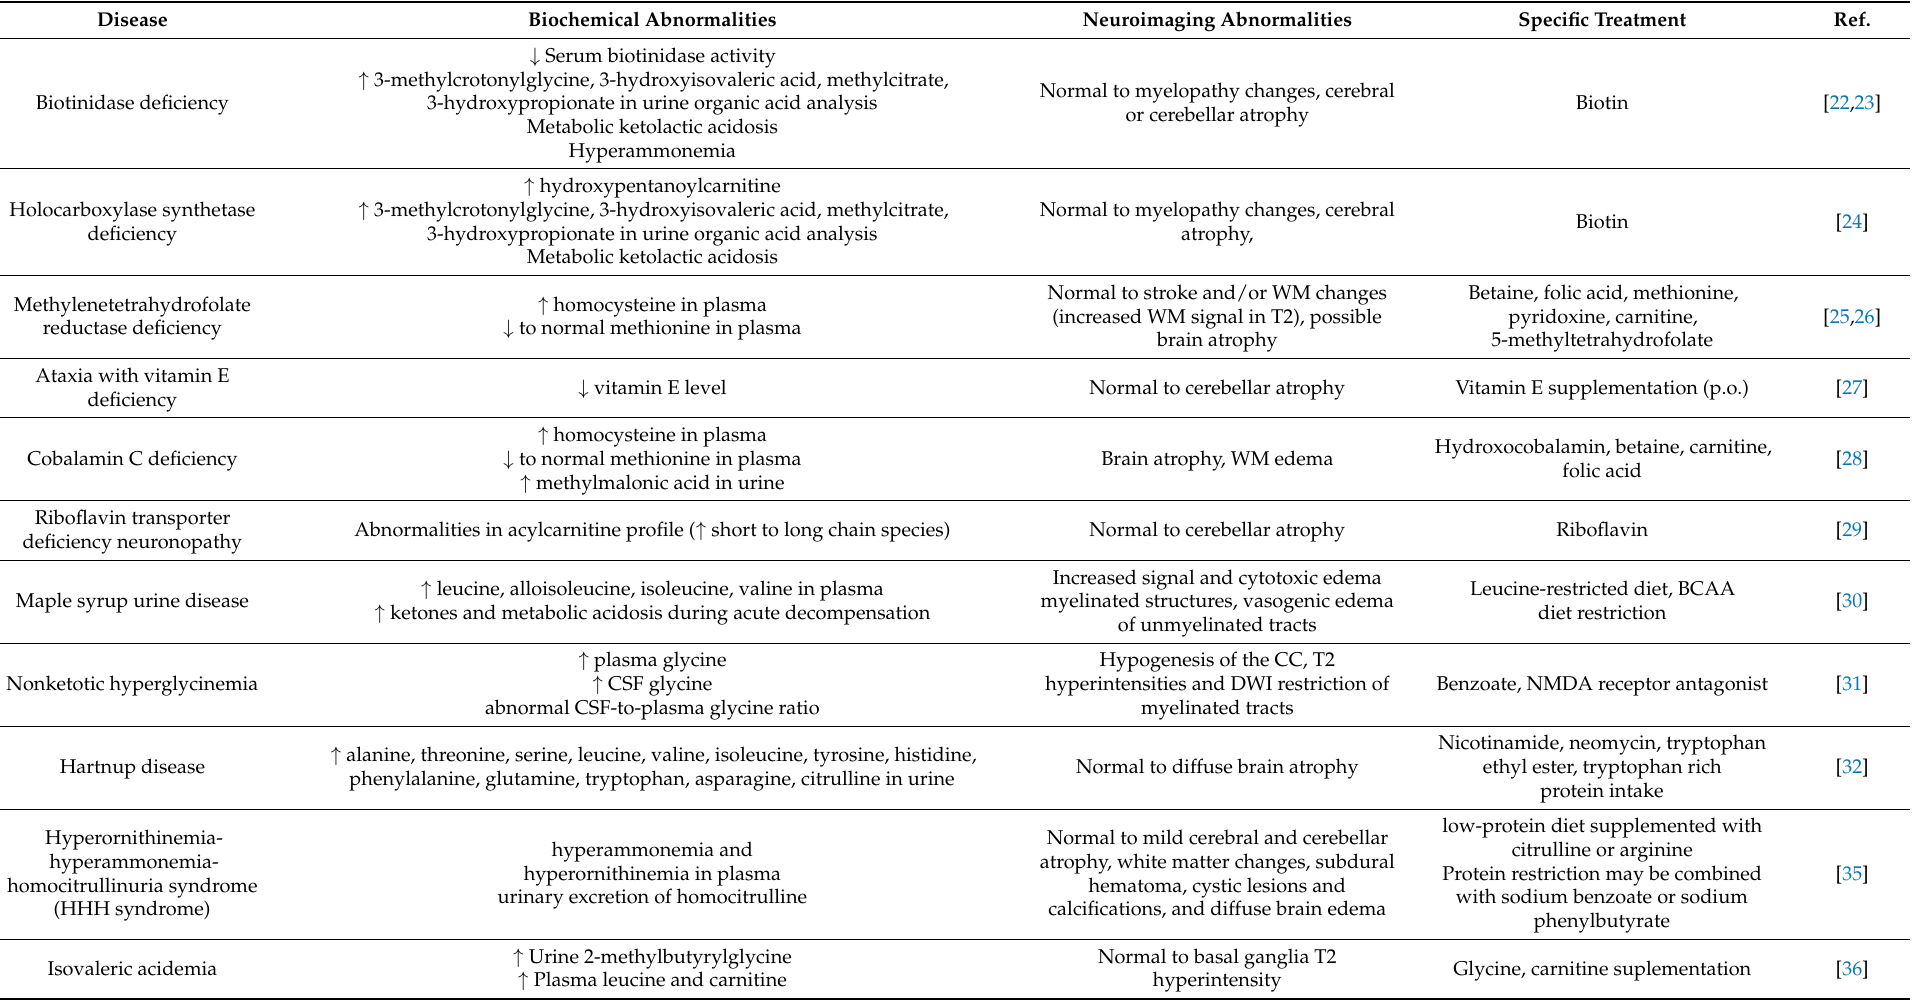
Table 3. Neurometabolic disorders presenting with ataxia: biochemical abnormalities, neuroimaging abnormalities, and disease-specific